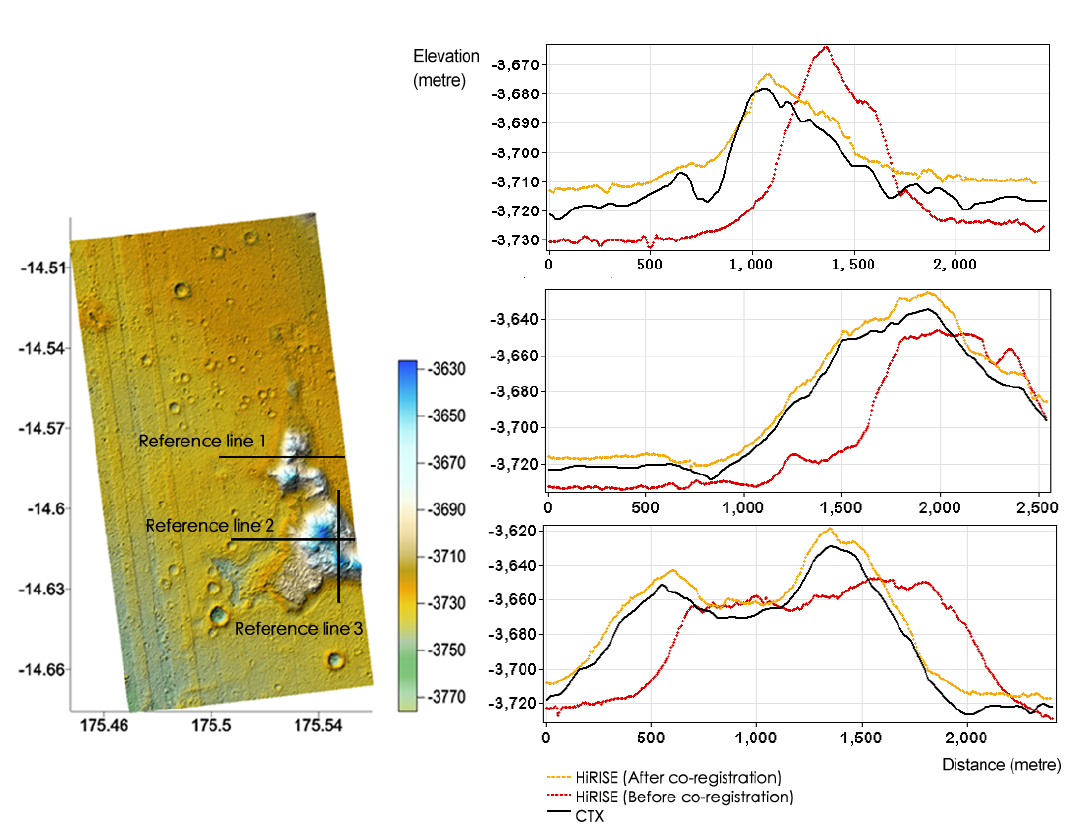
Figure 6. Profile comparison between the CTX and HiRISE DEMs before and after co-registration.